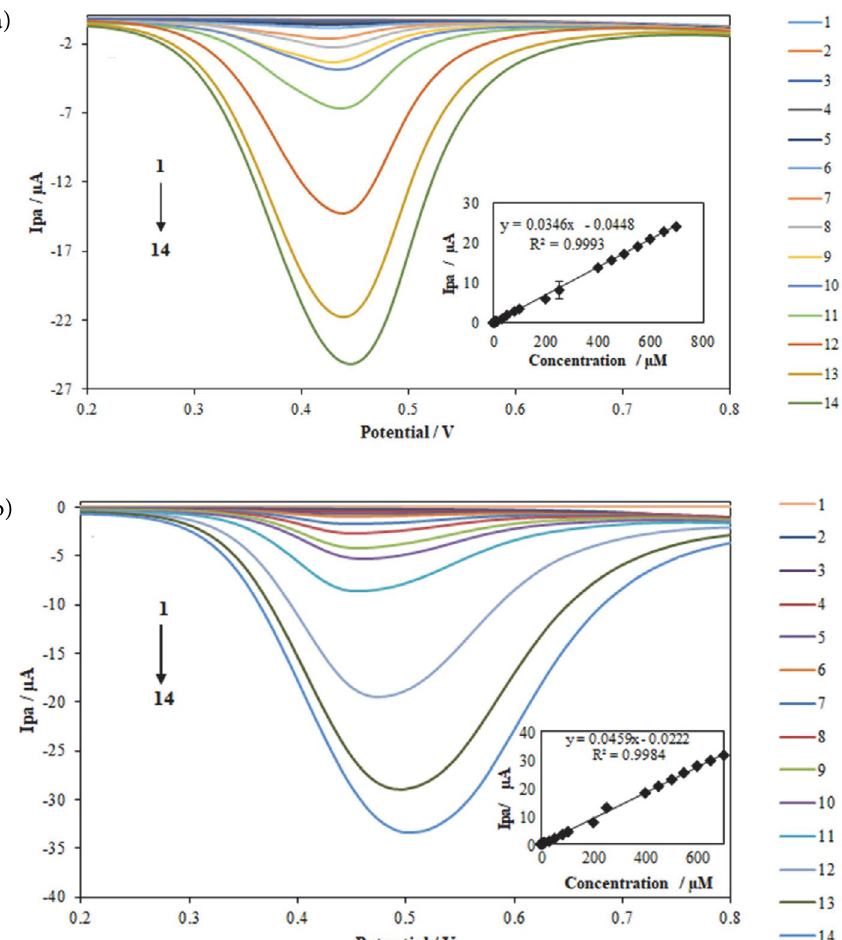
Fig. 7 a . AdsDPV voltammograms of the different concentrations of HQ on NSC modified electrode in pH 2.0 Britton Robinson buffer (1) blank , (2–14): 1.0 × 10 −8 , 1.0 × 10 −7 , 1.0 × 10 –6 , 5.0 × 10 −6 , 1.0 × 10 −5 , 3.0 × 10 −5 , 5.0 × 10 −5 , 8.0 × 10 −5 , 1.0 × 10 −4 , 2.0 × 10 −4 , 4.0 × 10 −4 , 6.0 × 10 −4 , 7.0 × 10 −4 molL –1 ; b . AdsSW voltammograms of HQ at different concentrations. (1) blank , (2–14): 1.0 × 10 −8 , 1.0 × 10 −7 , 1.0 × 10 –6 , 5.0 × 10 −6 , 1.0 × 10 −5 , 3.0 × 10 −5 , 5.0 × 10 −5 , 8.0 × 10 −5 , 1.0 × 10 −4 , 2.0 × 10 −4 , 4.0 × 10 −4 , 6.0 × 10 −4 , 7.0 × 10 −4 molL –1